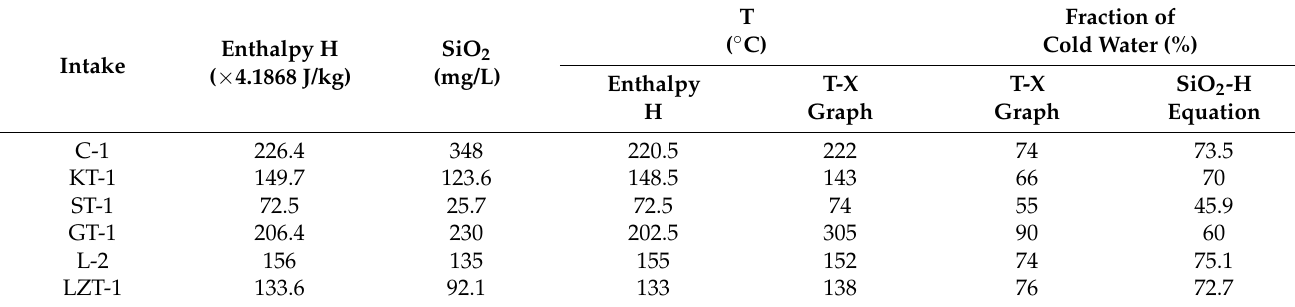
Table 4. Reservoir temperatures determined on the basis of the dependence of silica dissolution on the enthalpy of thermal waters (based on the determined enthalpy [72] and Figures 7 and 8); tem- perature in °C.